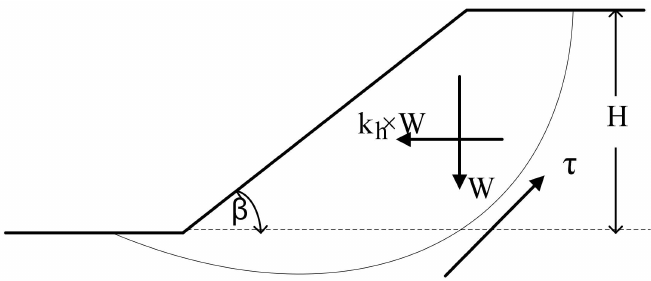
Figure 1. Limit equilibrium model for the stability analysis, (W: weight, τ : shear strength, k h : seismic coefficient, g: acceleration due to gravity, β : is slope inclination, H: slope